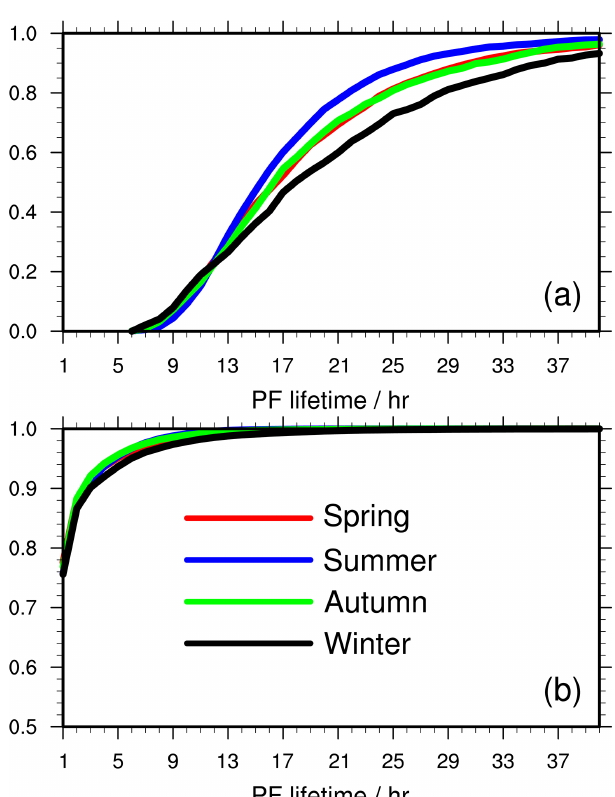
Figure A4. Seasonal cumulative distribution functions of PF-based lifetimes for (a) MCSs and (b) IDC in the data product domain for 2004–2017. Red lines denote spring, blue lines denote summer, green lines denote autumn, and black lines denote winter.